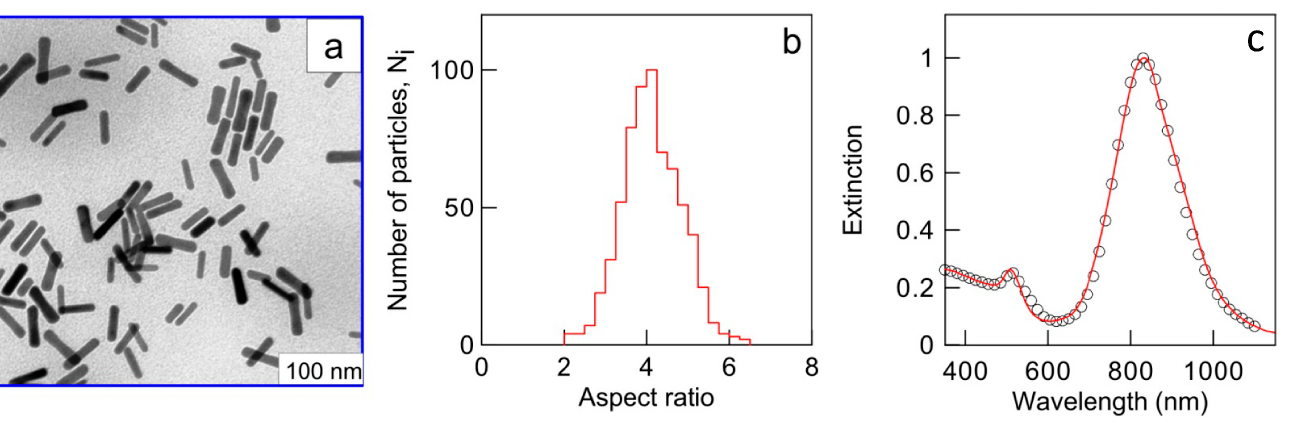
Figure 1. TEM image of Au nanorods ( a ), the aspect ratio histogram ( b ), and measured (black circles) and T-matrix-simulated extinction spectrum (red line) ( c ) (for details, the readers are referred to [22]).